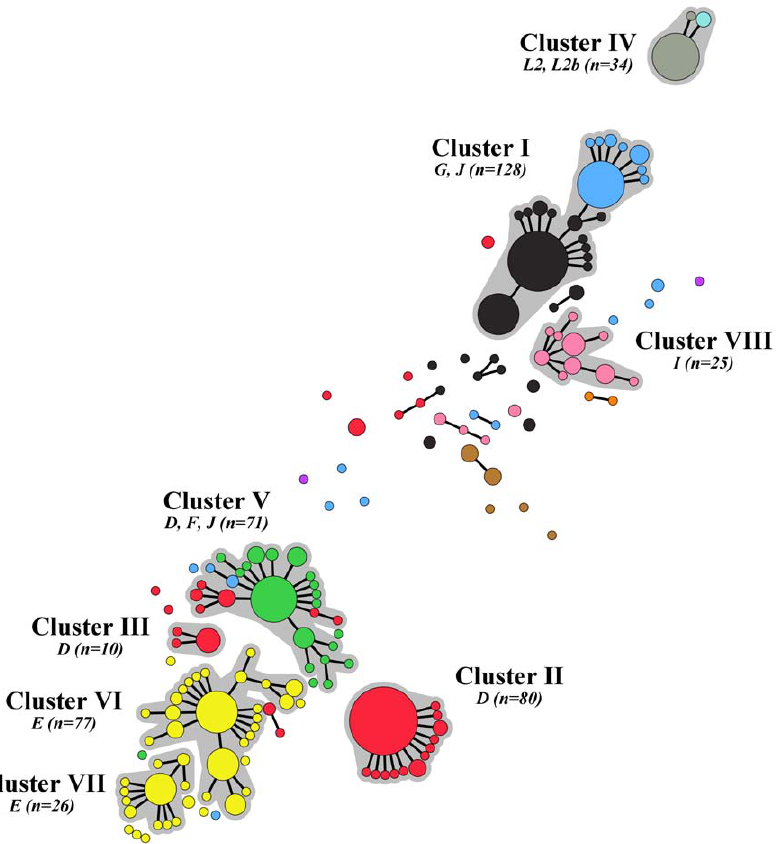
Figure 1. Minimum spanning tree showing ompA genovar type of 526 Chlamydiatrachomatis -positive samples from MSM and heterosexuals in Amsterdam between July 2008 and May 2010. Sizes of the node discs are proportional to the number of samples of each sequence type; branches show single locus variants (SLV); halos indicate clusters based on SLV; and letters indicate ompA genovar type. The color coding is: red, genovar D (n=115); yellow, genovar E (n=112); black, genovar G (n=102); green, genovar F (n=61); blue, genovar J (n=56); pink, genovar I (n=31); gray, genovar L2b (n=31); brown, genovar K (n=11); cyan, genovar L2 (n=3); purple, genovar B (n=2); and orange, genovar H (n=2).